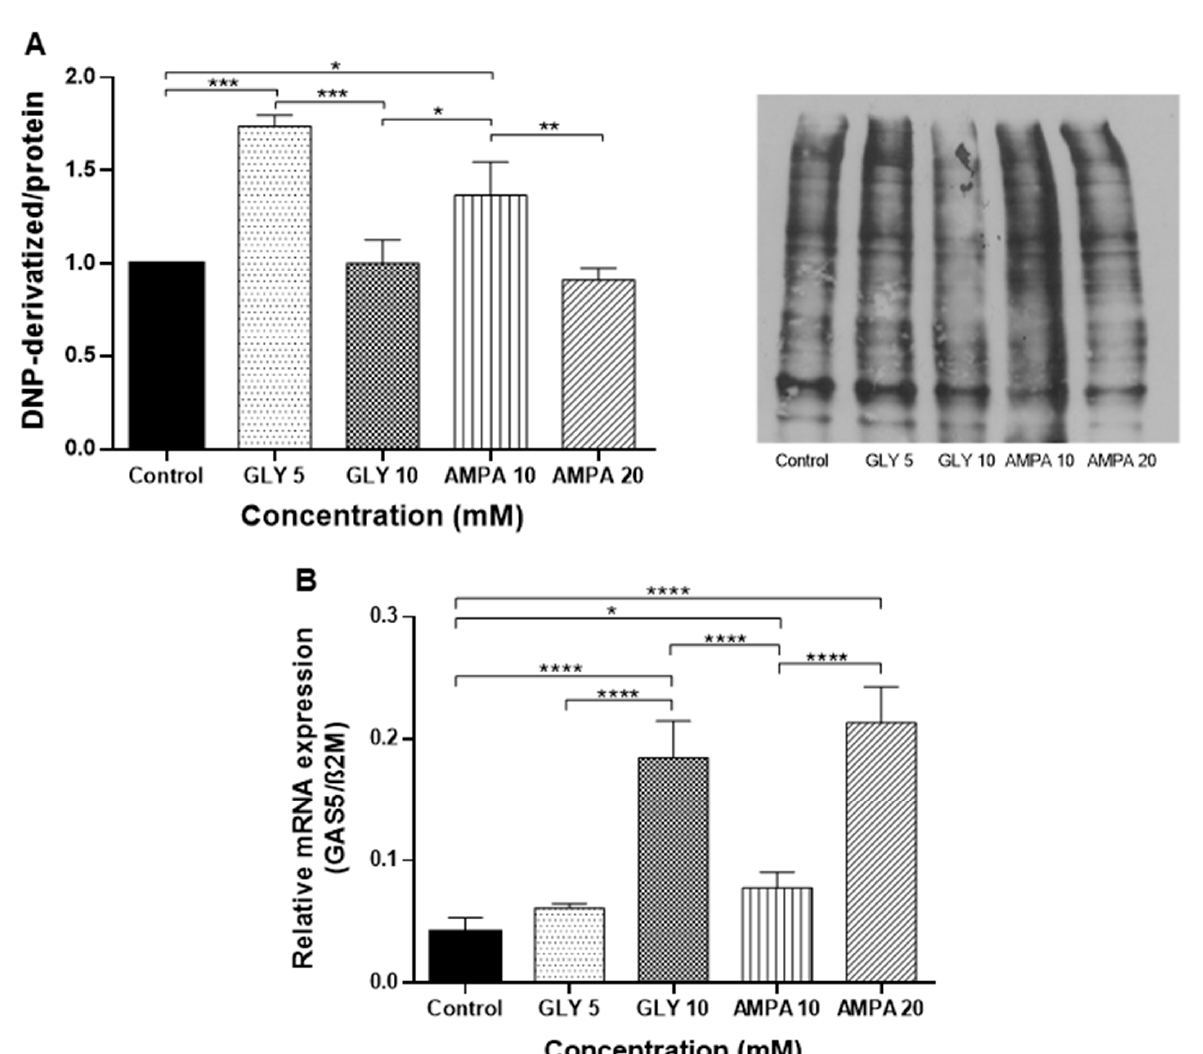
Figure 3. Protein oxidation assay and quantification of transcriptional levels of the growth arrest specific 5 (GAS5) in PNT2 cells. ( A ) Analysis of oxidized proteins from the PNT2 prostate cell line exposed to glyphosate (GLY) and aminomethylphosphonic acid (AMPA) for 48 h. ( B ) Expression of GAS5 by qPCR. β -2 microglobulin ( β 2M) was used as the reference. Results are expressed as means ± standard deviation of three independent tests performed in triplicate. * p < 0.05, ** p < 0.01, *** p < 0.001, **** p < 0.0001.